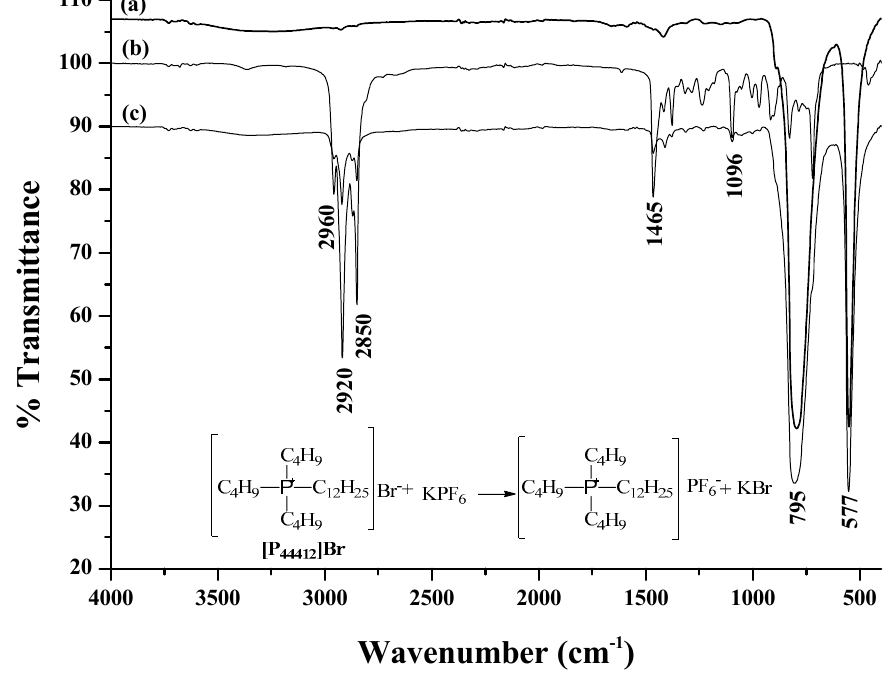
Figure 1. FT–IR spectra of ( a ) KPF 6 , ( b ) [P 44412 ]Br, and ( c ) the in situ ionic liquid when it was formed.